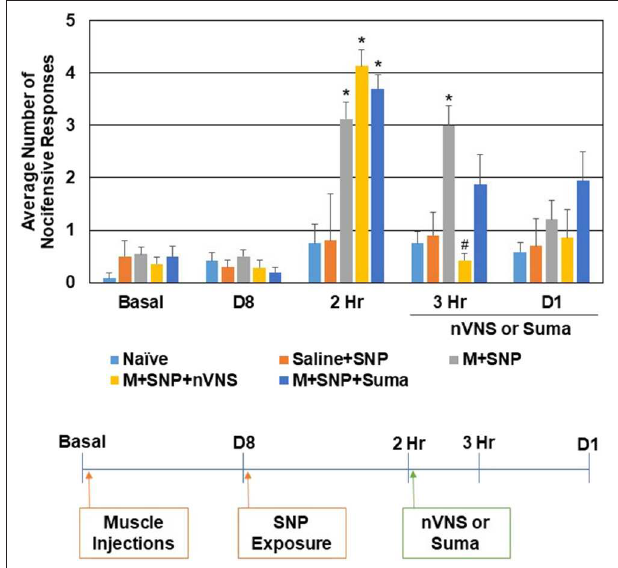
FIGURE 1 | nVNS and sumatriptan inhibit trigeminal nociception mediated by a pungent odor in sensitized animals. The average nocifensive head withdrawal response ± SEM of 5 applications to each side to mechanical stimuli are reported. Some animals were left untreated (Naïve), some were injected with saline in the trapezius (Saline) and exposed to the pungent extract from California Bay Laurel leaves (CBL), while others were injected with complete Freund’s adjuvant 8 days prior to exposure to CBL (M + CBL) and nociceptive responses determined at 2h, 3h, and 1 day post CBL exposure. Some of the M + CBL animals were treated with nVNS or sumatriptan and nociception measured 1h and 1 day post treatment. * P < 0.05 when compared to Naïve while # P < 0.05 compared to M + CBL.